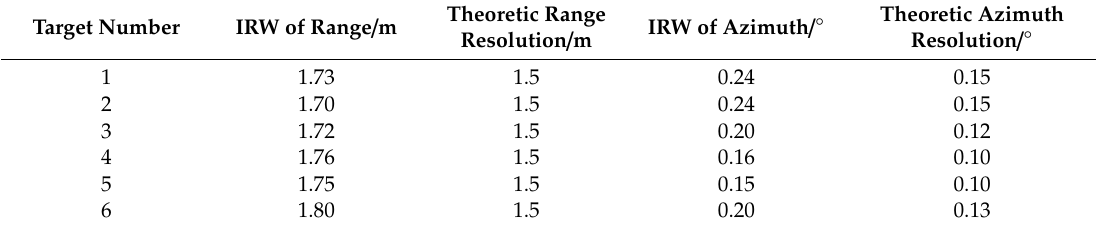
Table 4. Imaging resolution.